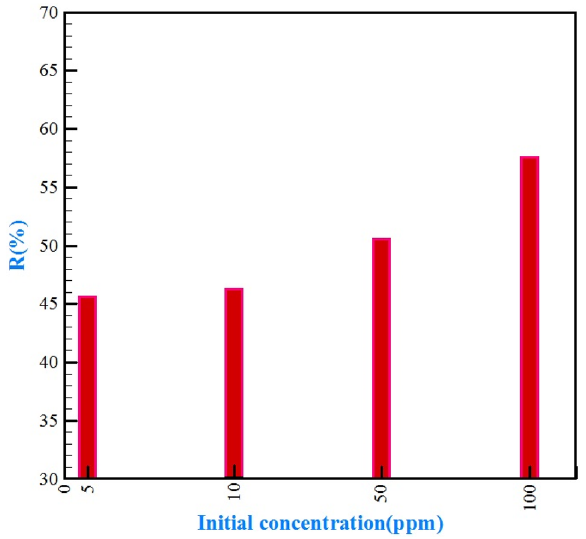
Figure 10. The effect of initial chromium concentration on separation